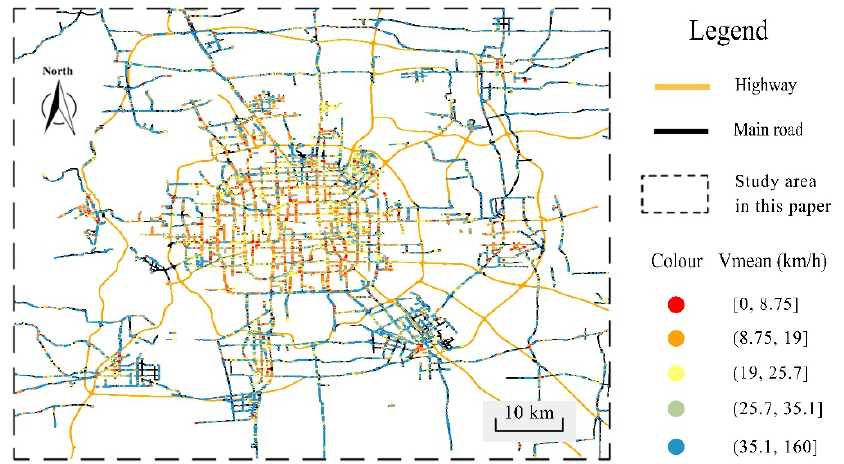
Figure 8. The traffic condition at the road grids, evaluated from the average velocity of vehicles. Vmean: mean velocity.